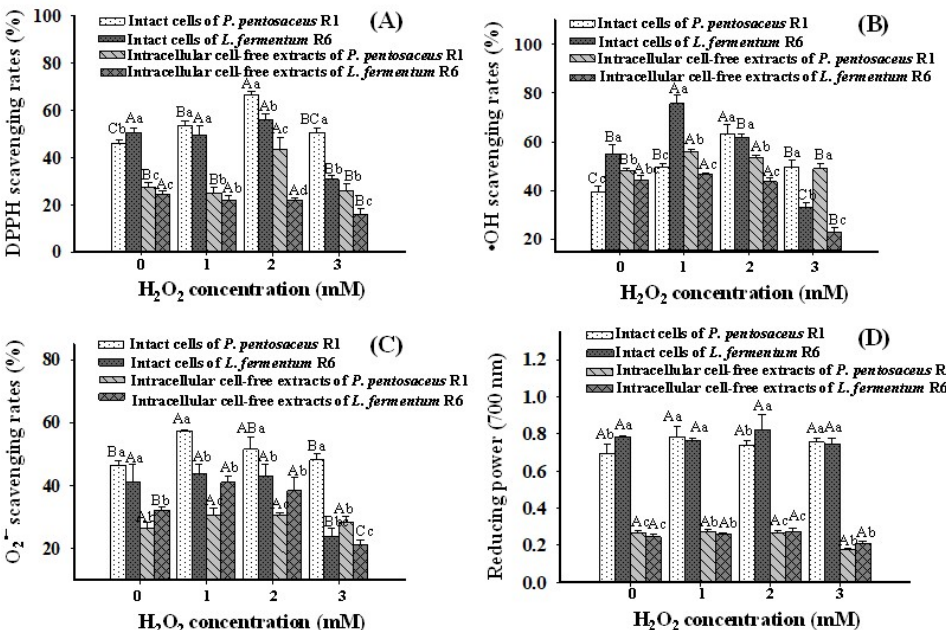
Figure 5. Changes in 2 (cid:48) ,2 (cid:48) -diphenyl-1-picrylhydrazyl (DPPH) radical scavenging rates (%) ( A ), hydroxyl radical ( • OH) scavenging rates (%) ( B ), superoxide anion radical (O 2 •− ) scavenging rates (%) ( C ), and reducing powers ( D ) of Pediococcus pentosaceus R1 and Lactobacillus fermentum R6 after incubation in MRS broth with different H 2 O 2 concentrations for 1 h. Different uppercase letters (A–C) denote statistical differences ( p < 0.05) of the same components in the same strain (intact cell or intracellular cell-free extract) under different H 2 O 2 concentrations; different lowercase letters (a–d) denote statistical differences ( p < 0.05) for both strains within the same H 2 O 2